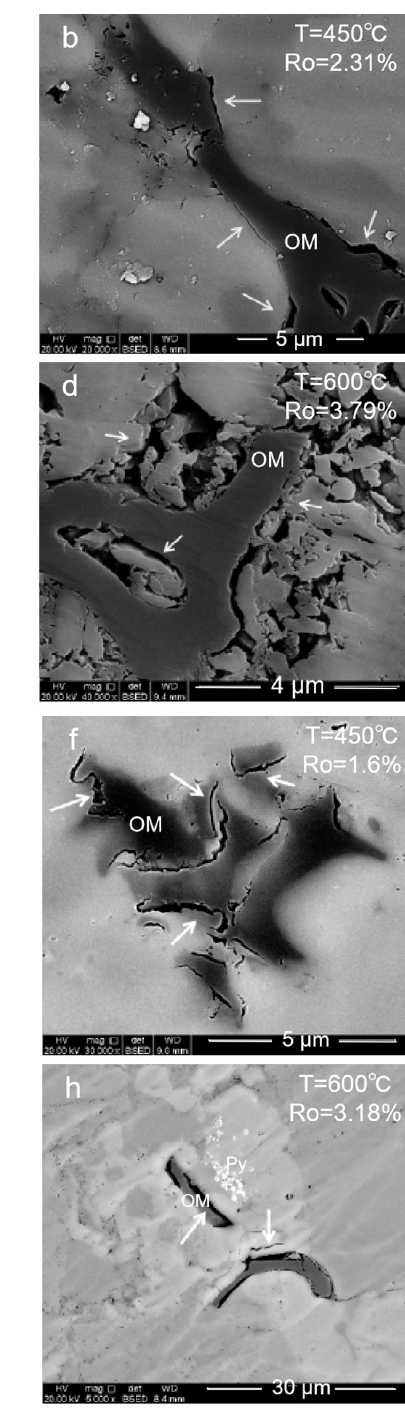
Figure 4. Evolution of the organic edge seam in two groups under different temperatures. ( a ) Group 1, semiclosed system, T = 400 °C, edge seams between the organic matter and the inorganic minerals. ( b ) Group 1, semiclosed system, T = 450 °C, edge seams enlarge. ( c ) Group 1, semiclosed system, T = 500 °C, organic inner shrink seam and organic edge seam. ( d ) Group 1, semiclosed system, T = 600 °C, organic matter edge seams and inorganic pores are connected. ( e ) Group 2, open system, T = 400 °C, organic edge seam was not developed. ( f ) Group 2, open system, T = 450 °C, the organic edge seam was not developed. ( g ) Group 2, open system, T = 500 °C, marginal and organic edge seams were developed in agglomerated organic matter. ( h ) Group 2, open system, T = 600 °C, the organic edge seam is squeezed and deformed.